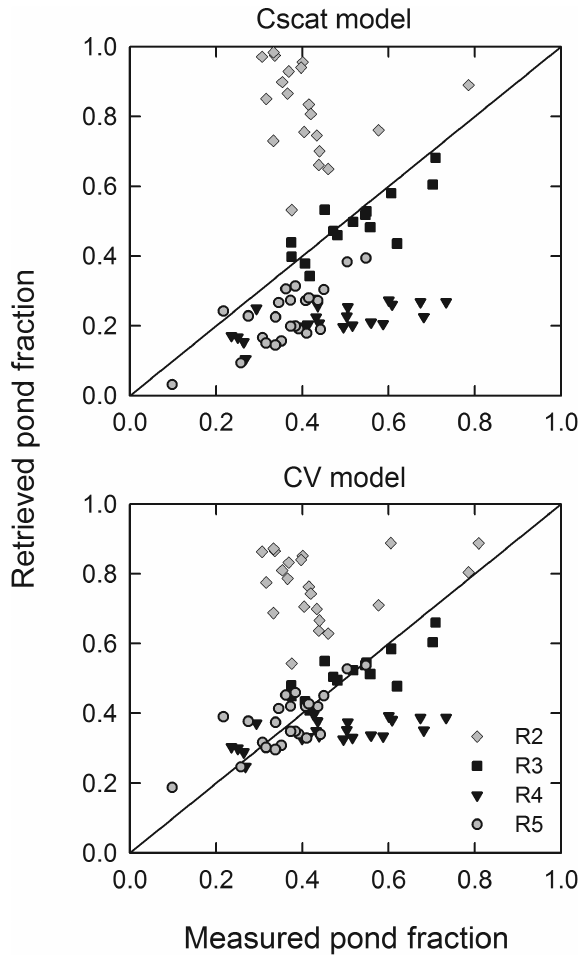
Figure 8. Comparison of pond fractions, retrieved from Radarsat-2 scenes R2–R5 using models Cscat (top) and CV (bottom), to ob- served pond fractions from aerial